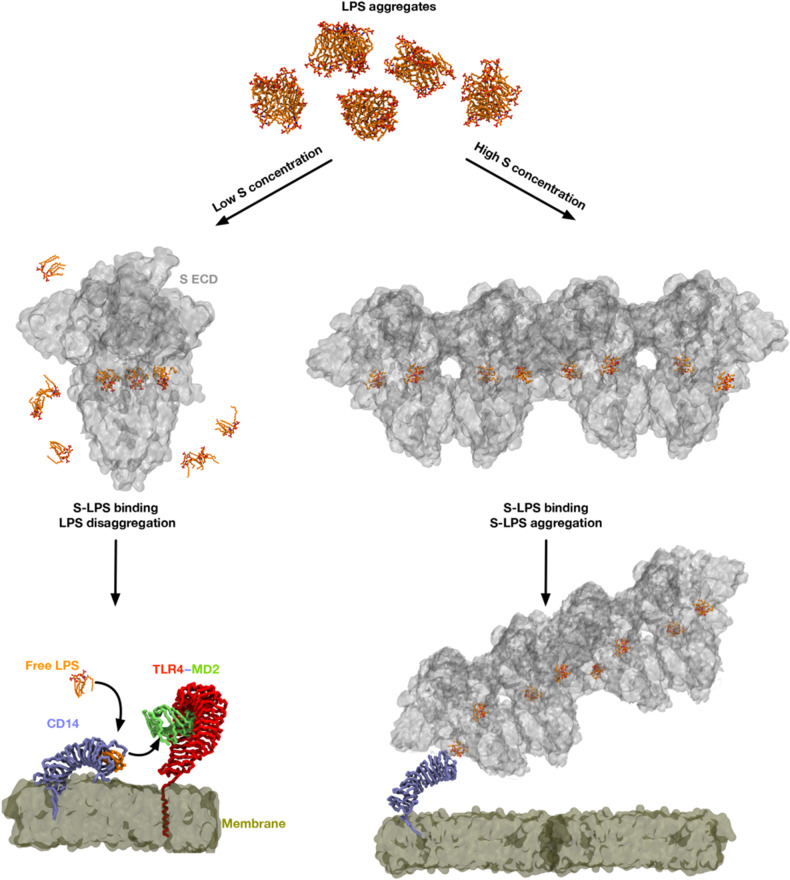
Proposed proinflammatory mechanism of SARS-CoV-2 S protein. In the absence of S protein, LPS micelles are present. At low S protein concentrations, some LPS molecules bind to S protein resulting in disaggregation of the LPS aggregates. Free LPS molecules are then able to bind to the LPS receptor, CD14, before being transferred to the TLR4/MD2 complex, which activates downstream signaling. At high S protein concentrations, most LPS molecules are bound to the S protein, and the S protein‒LPS complex then forms large aggregates [modelled based on S protein dimer of trimers (Bangaru et al., 2020)], which may promote inflammatory responses.